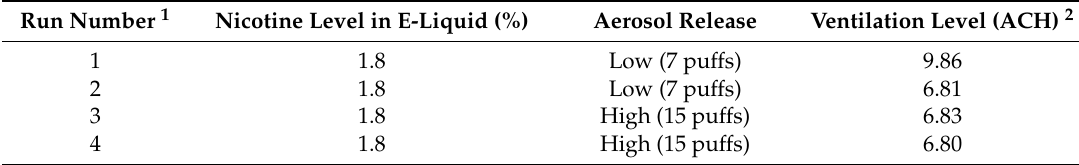
Table 1. Input data from four runs using one e-cigarette as described in the text.